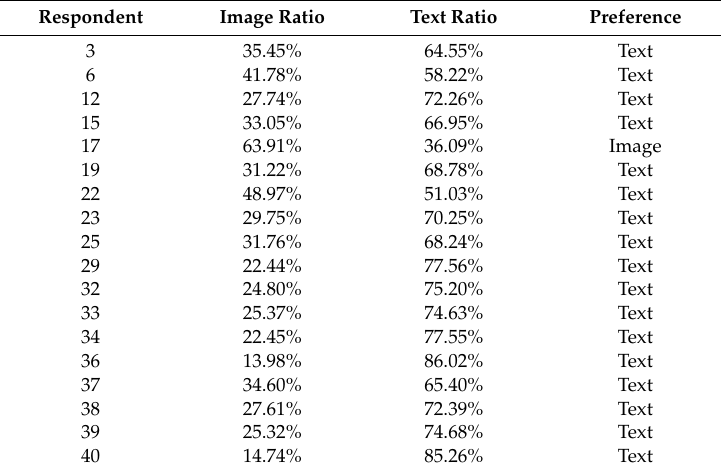
Table 10. Respondents with low anxiety.